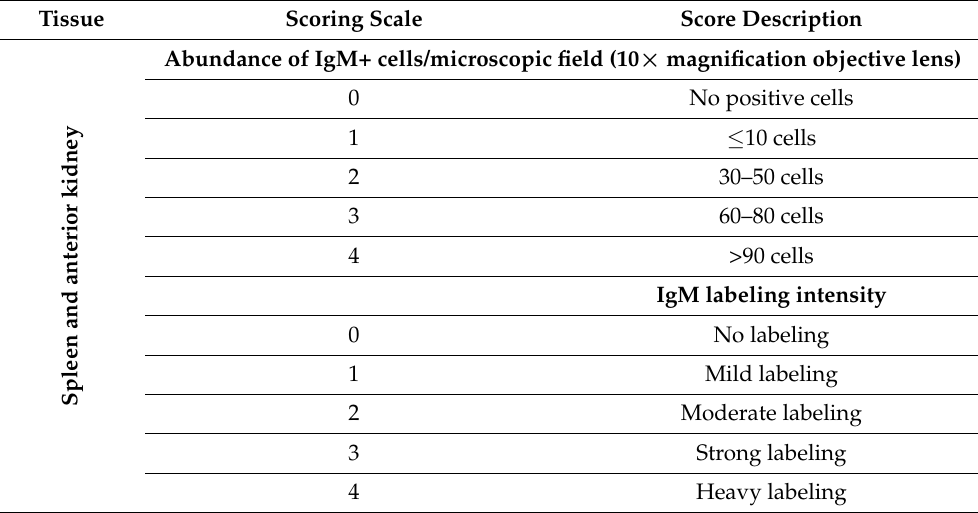
Table 2. Scoring scale of secreted IgM and IgM + cells in spleen and anterior kidney after P33 vaccination.